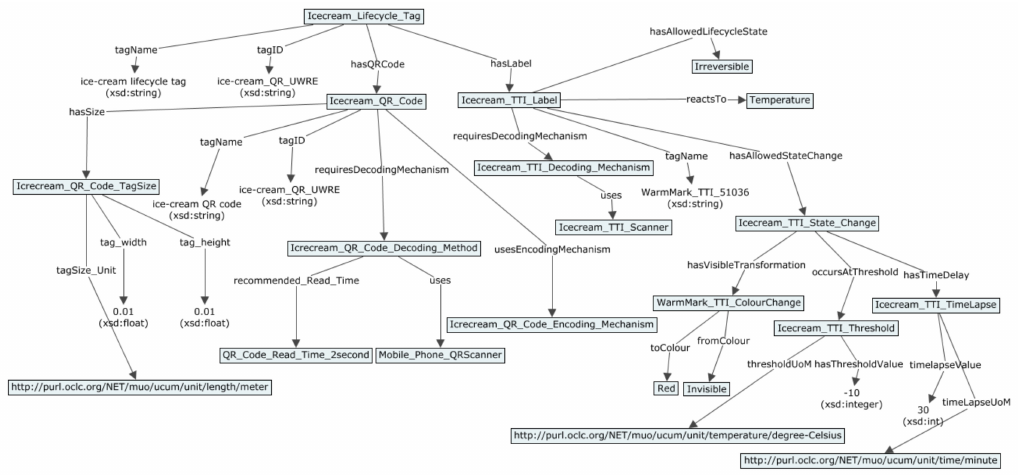
Figure 25. Semantic model for ice cream use case.